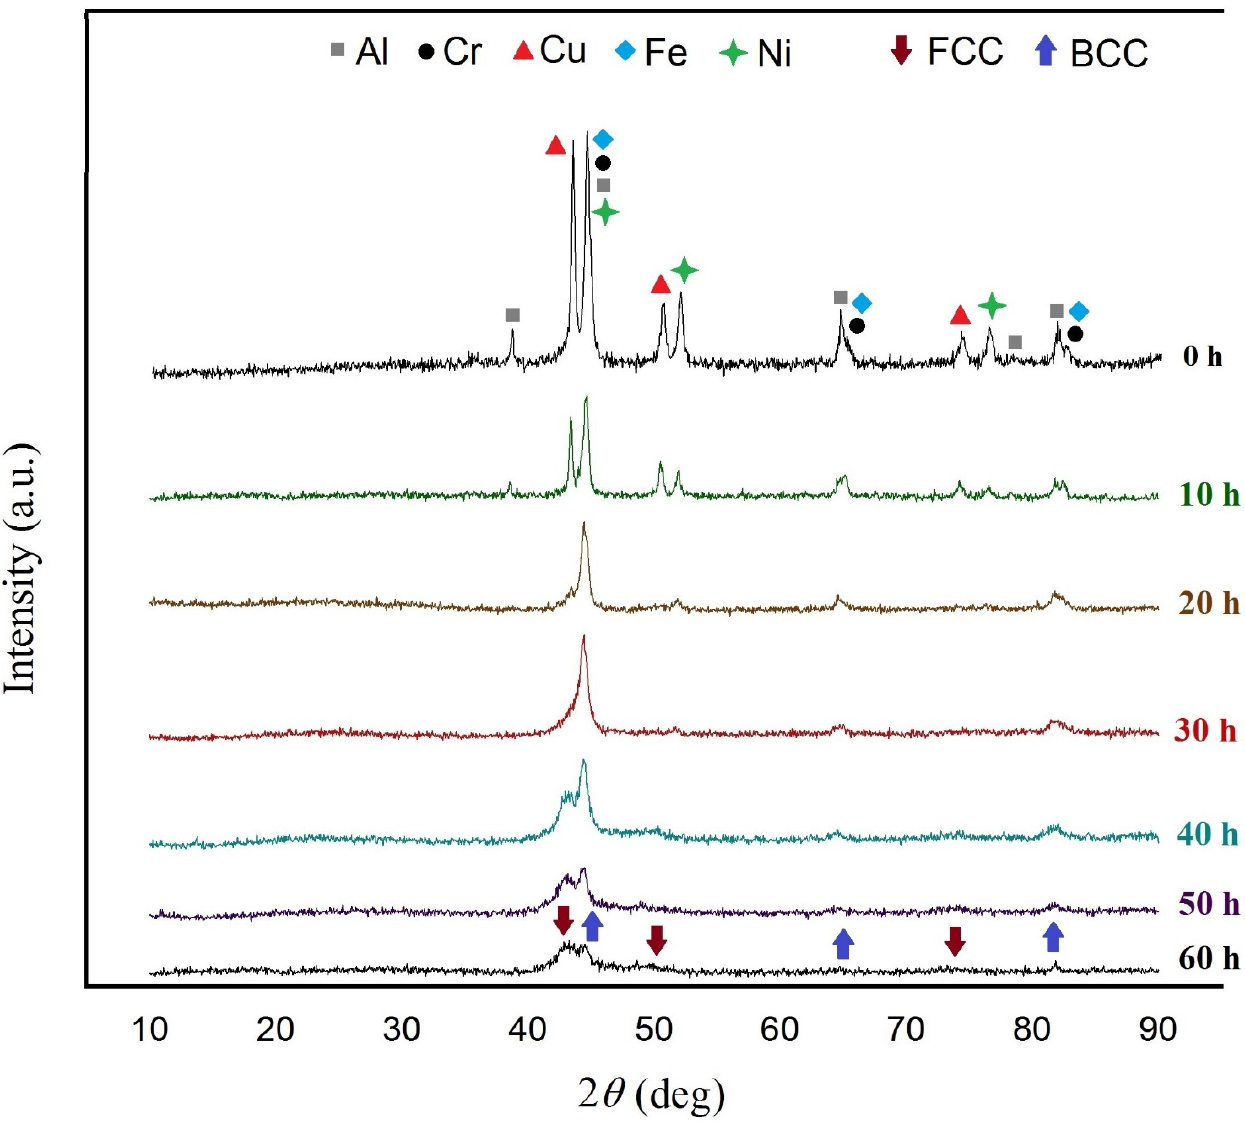
Figure 4. XRD patterns of the AlCrCuFeNi HEA after different time periods of mechanical alloying.